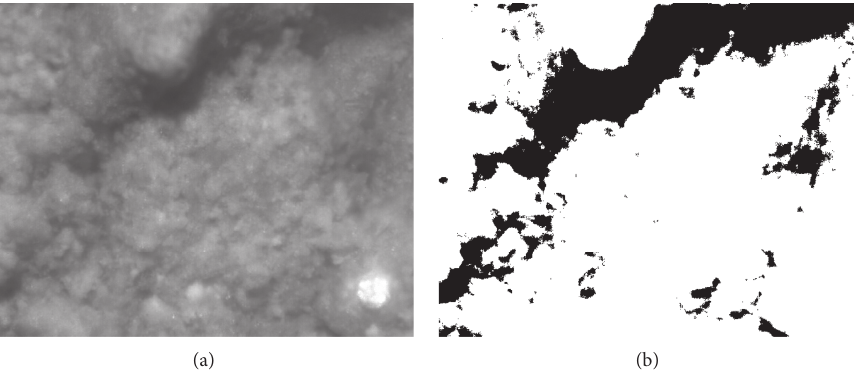
Figure 17: Binary image processing: (a) initial image; (b) binarized image.